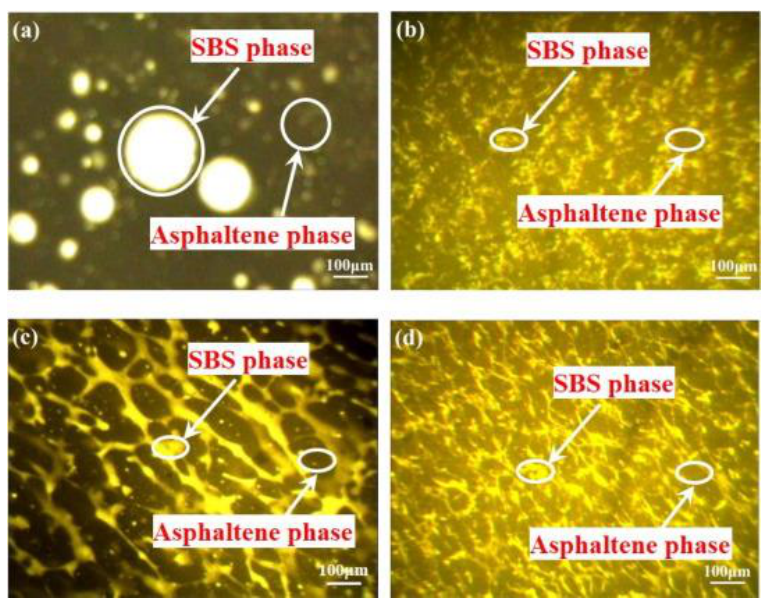
Figure 8. Fluorescence micrographs of ( a ) SBS – modified asphalt; GO/SBS-modified asphalt with different GO content of ( b ) 0.1 wt%; ( c ) 0.3 wt%; ( d ) 0.6 wt%. Reproduced with permission of [76]. © 2022 The Authors. Published by Elsevier Ltd.